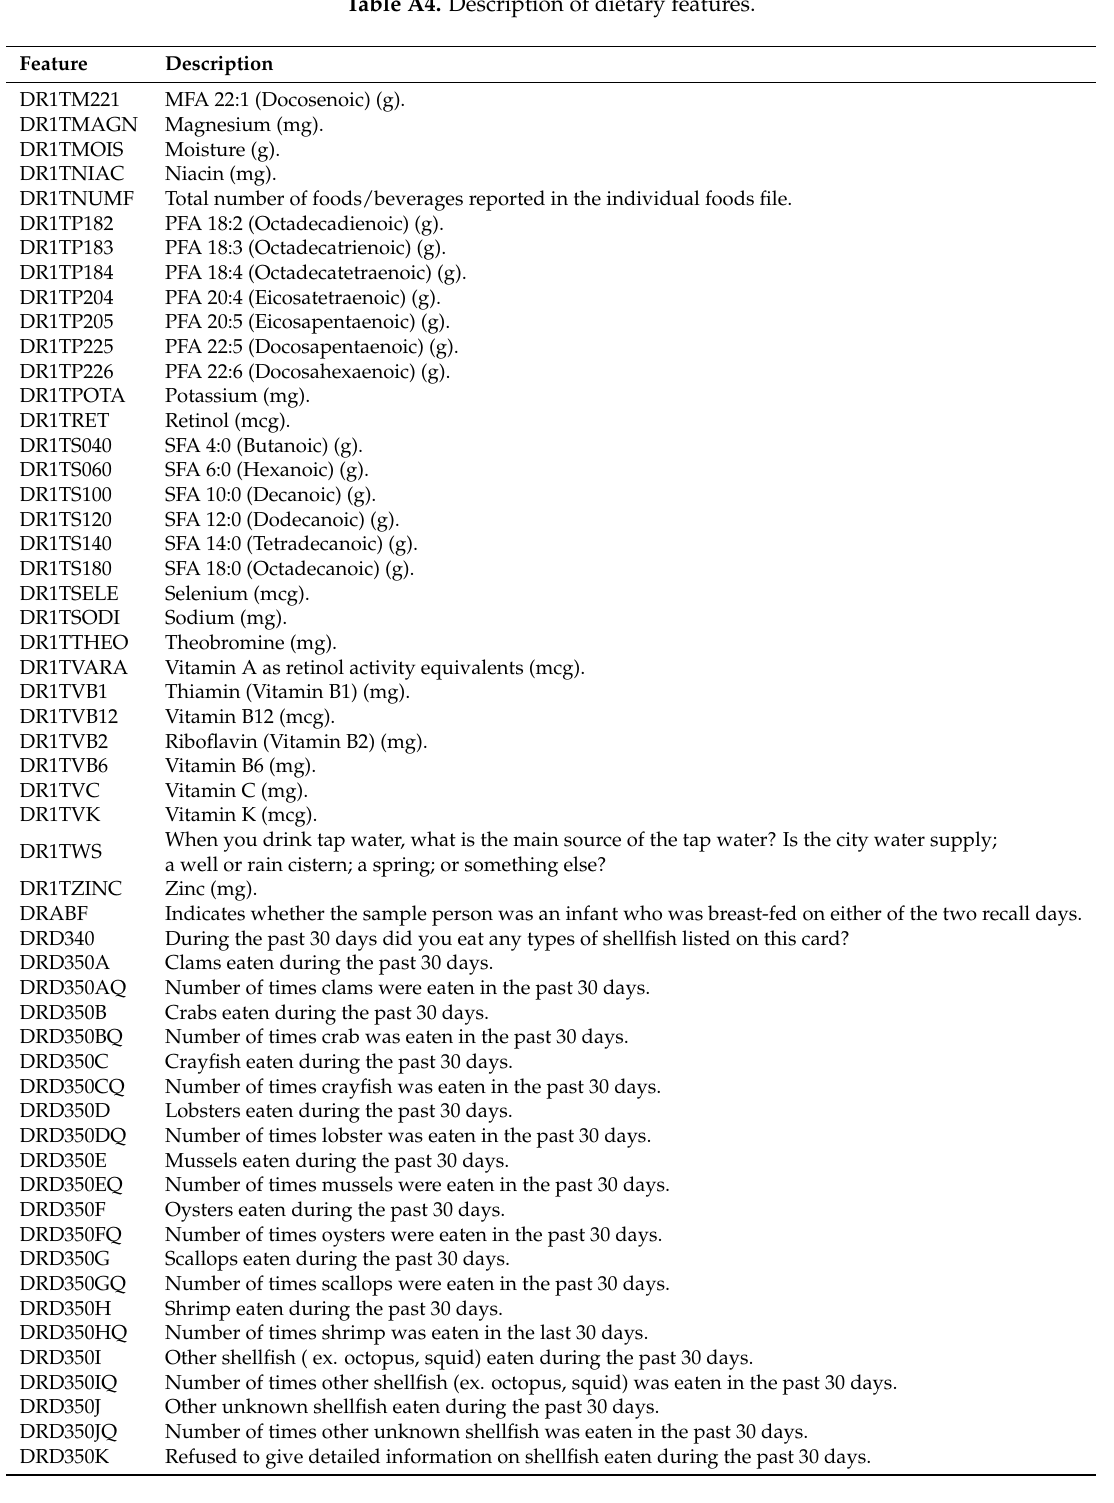
Table A4. Description of dietary